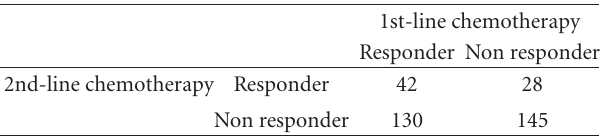
Table 5: Disease control rate of first-line chemotherapy against disease control rate of second-line